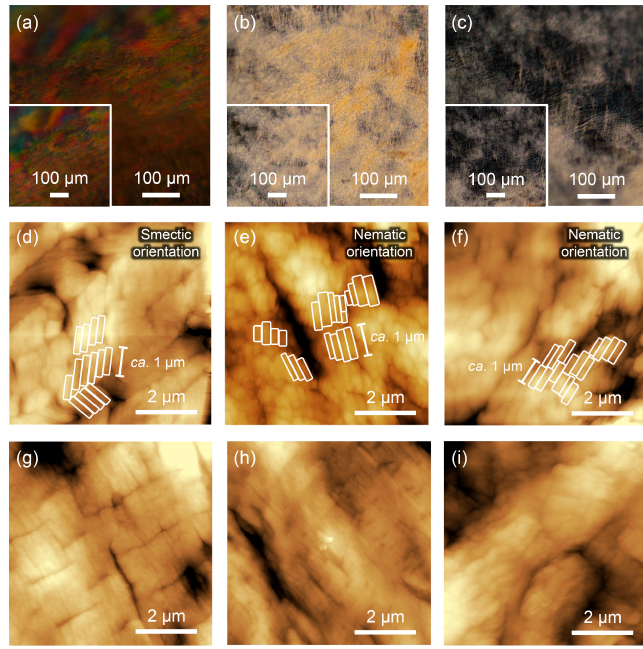
Figure 3. Microscopic observations of the M13 phage films prepared by flow-induced orientation methods. ( a – c ) Polarized optical microscopy (POM) images of the thermally treated M13 phage